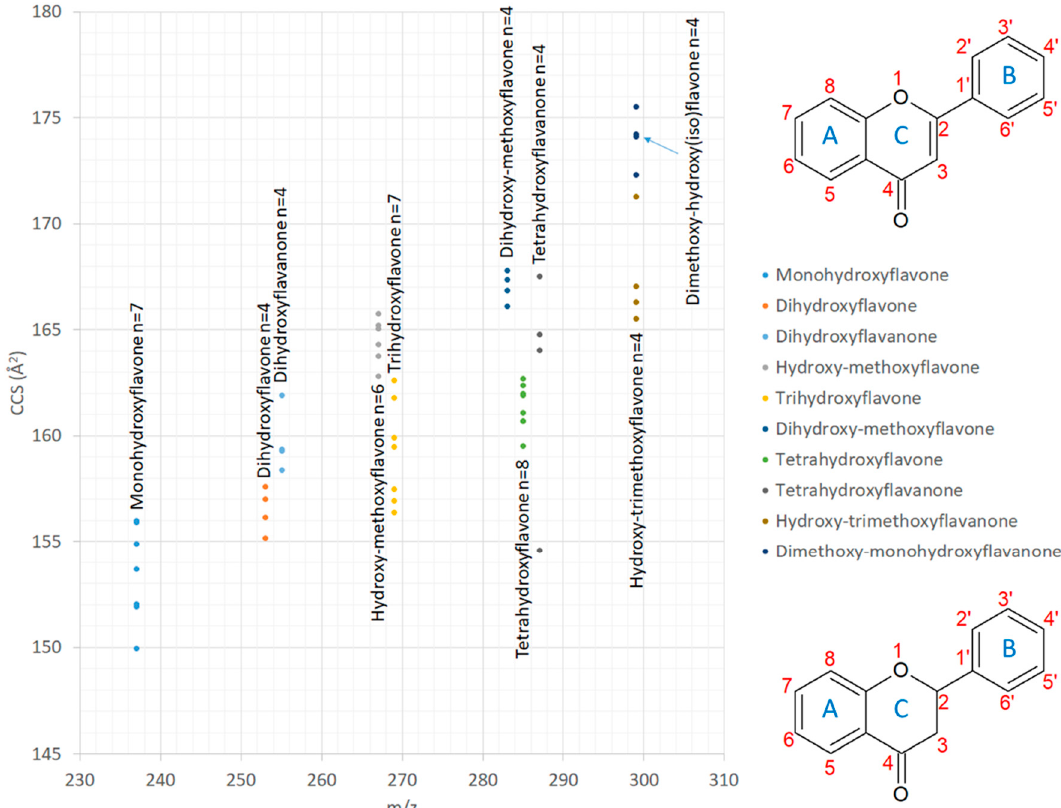
Figure 4. Relative mobilities of several flavonoid isomer classes selected from Figure S1 and general ring structures for flavones (top) and flavanones (bottom) with rings and functional positions labeled. The m / z is indicated on the x-axis and the CCS on the y-axis. The n value represents the number of isomers in each group. Many of the isomers have di ff erent CCS and could be di ff erentiated. Isomers with the same CCS would need to elute at di ff erent times from the UHPLC to be di ff erentiated. General ring structures for flavones and flavanones.